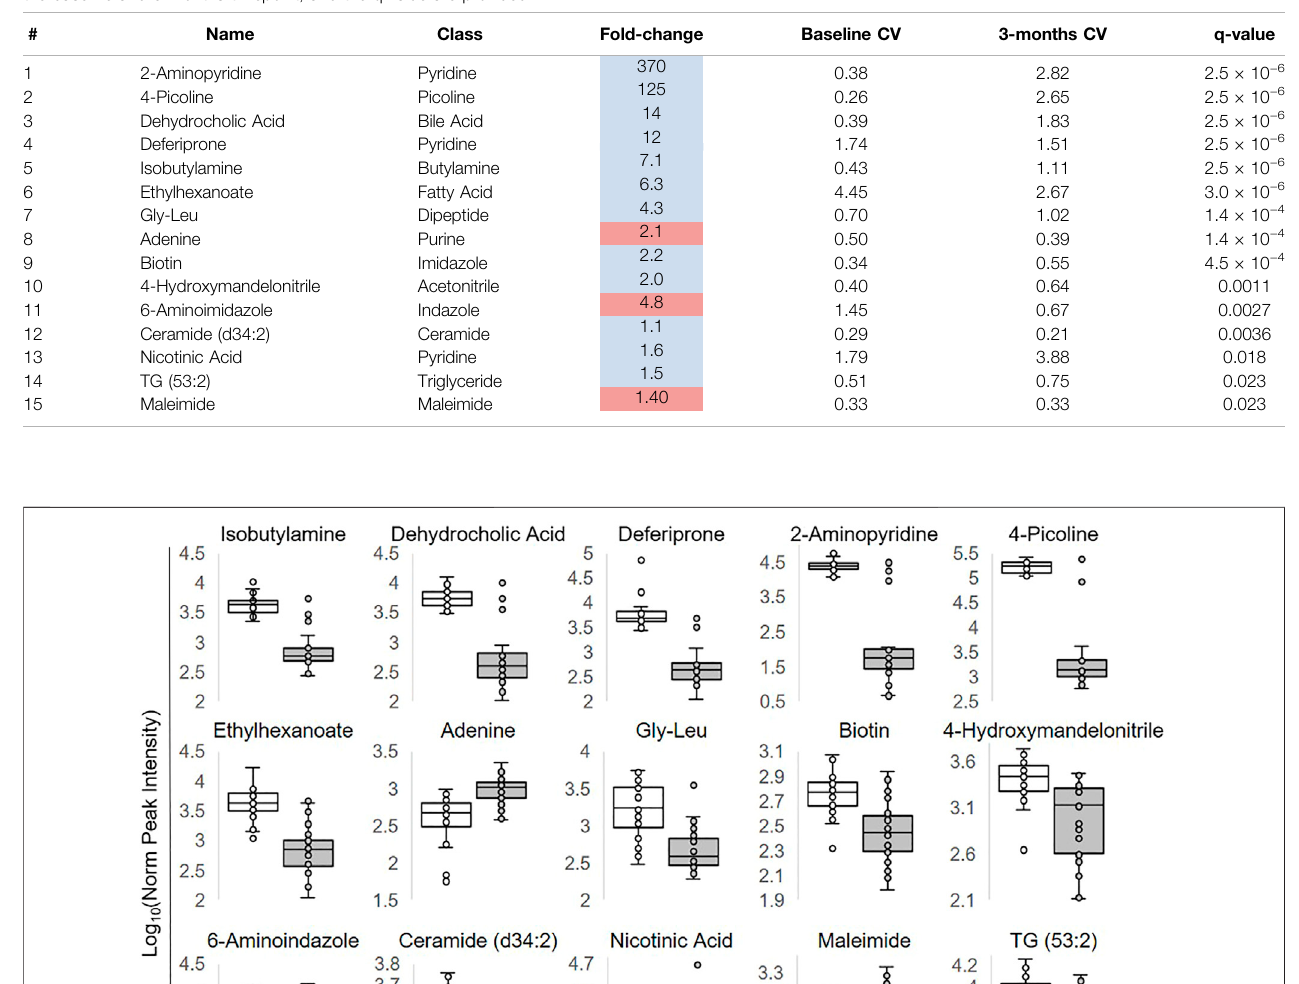
Frontiers in Pharmacology |